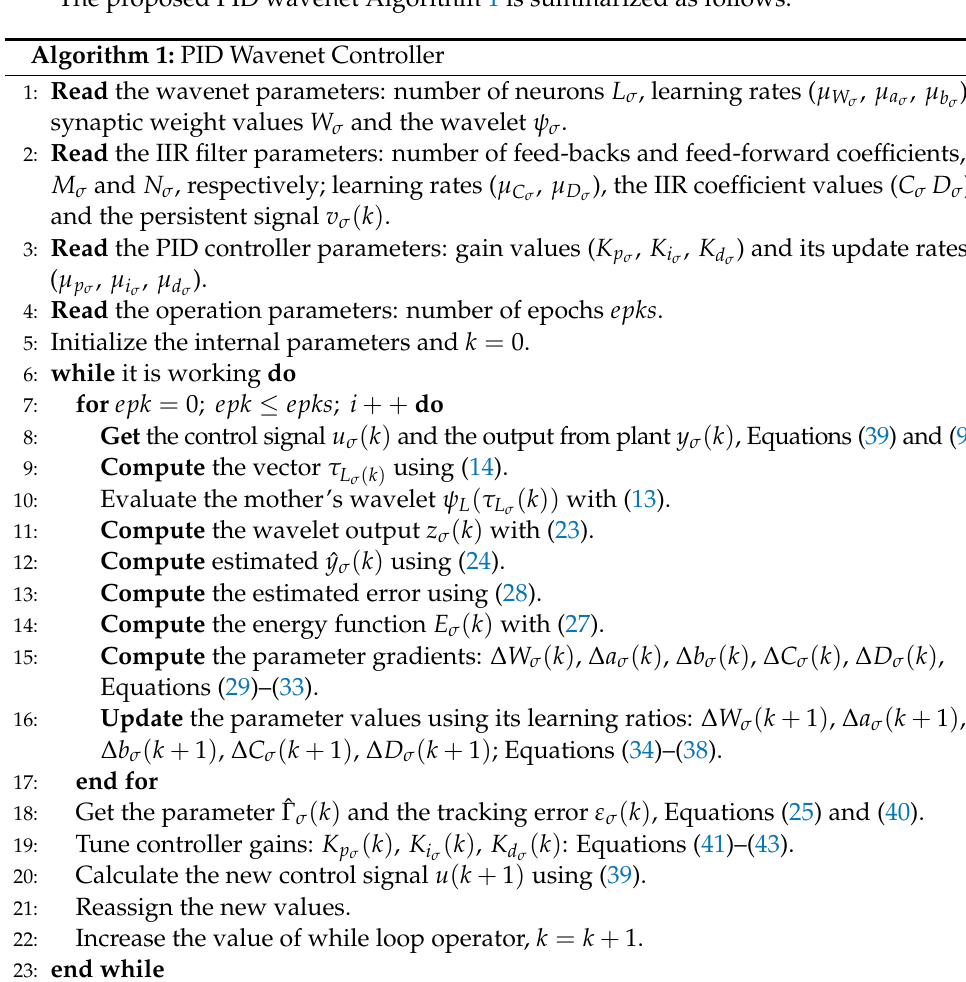
Algorithm 1: PID Wavenet